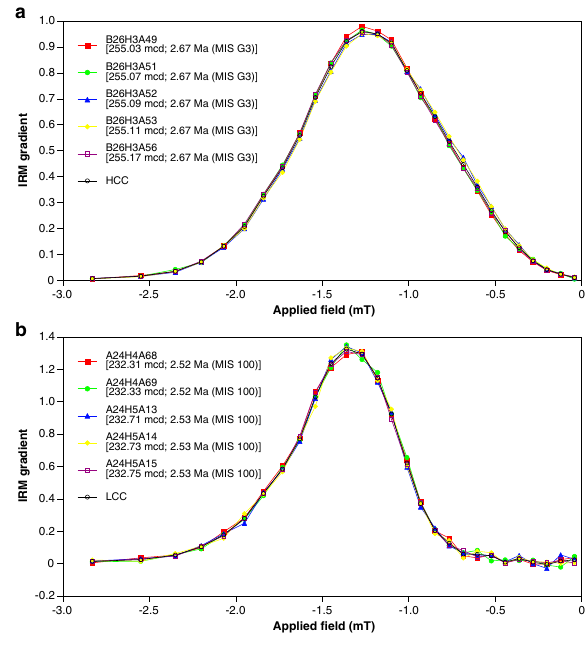
Fig. 6 IRM gradient curves. a HCC. b LCC.